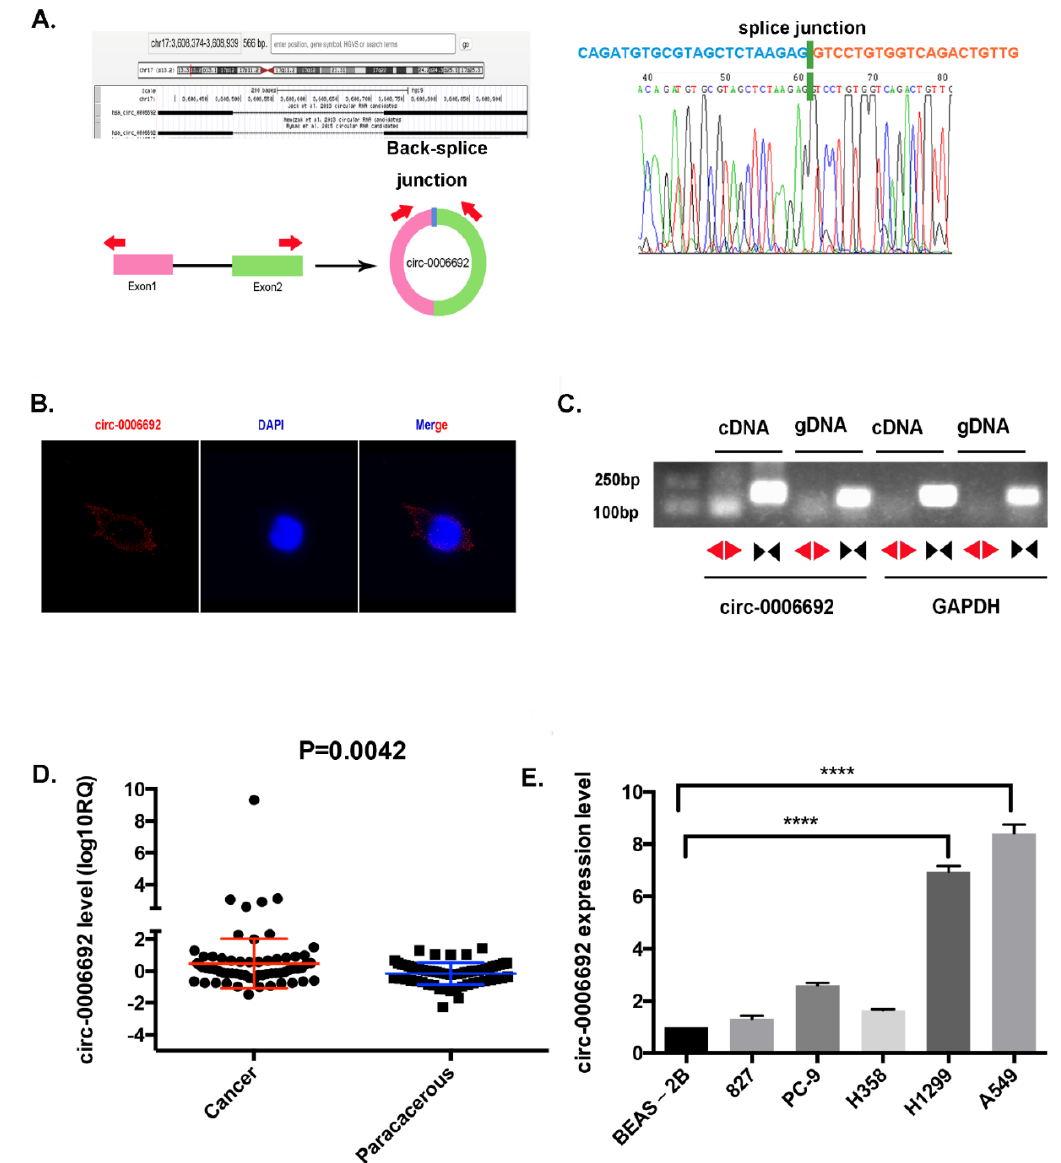
Figure 1. hsa_circ_0006692 is up-regulated in NSCLC. ( A ) hsa_ circ-0006692 locus sketch. The expres- sion of circ-0006692 (circbase ID: hsa_circ_0006692) was verified by RT-PCR and Sanger sequencing. Red arrows represent divergent primers used to amplify the genomic region of circ-0006692 containing backsplice junction site (JCT); ( B ) Representative image of RNA fluorescence in situ hybridization for endogenous hsa_circ_0006692, shown localization of hsa_circ_0006692 in the cytoplasm of A549 cells. The cellular nucleus was subjected to counterstaining with 4,6-diamidino-2-phenylindole (DAPI). Scale bar, 5 µ m; ( C ) In A549 cells, divergent primers amplified hsa_circ_0006692 in cDNA JCT, but not in genomic DNA (gDNA), and convergent primers amplify both hsa_circ_0006692 JCT and linear circ-0006692. GAPDH was used as a reference control. Red and black arrows represent divergent and convergent primers, respectively. ( D ) Expression of hsa_circ_0006692 in 60 paired lung cancer and adjacent tissues; ( E ) Expression of hsa_circ_0006692 in five human lung carcinoma cell lines (HCC827, PC-9, H358, H1299, and A549) and one normal human lung epithelial cell line (BEAS-2B). **** p < 0.0001